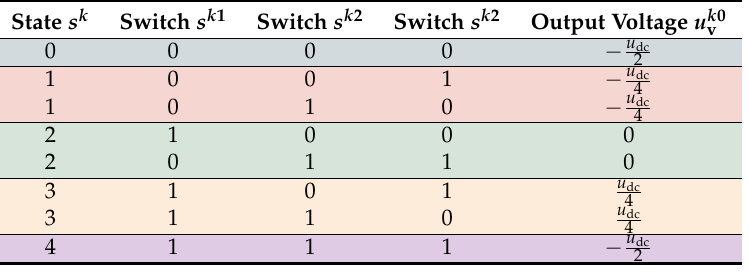
Table 1. Switching states and output voltage levels of a single 5-level ANPC inverter